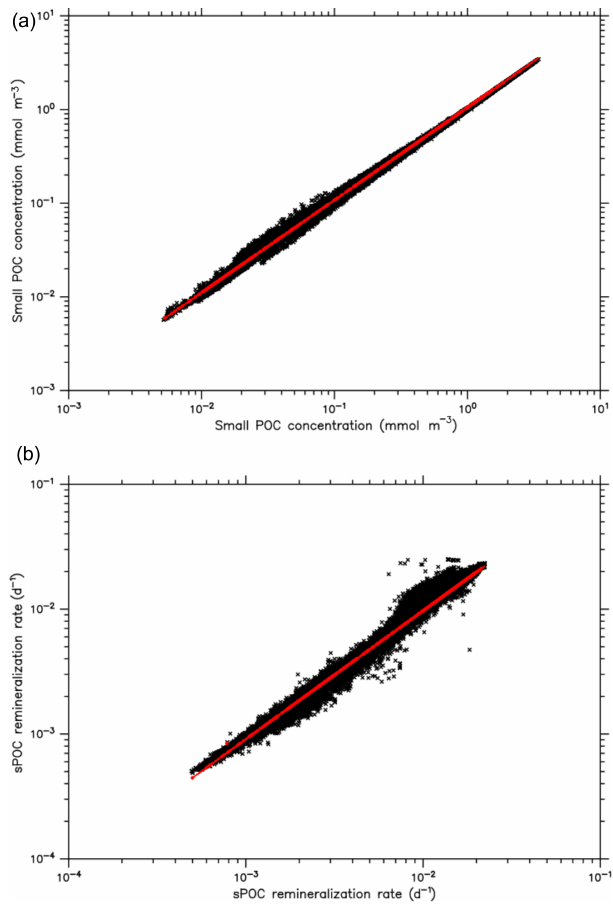
Figure 9. Scatter diagrams of the small POC concentration (in mmolm − 3 , top panel) and the remineralisation rate (in d − 1 , bottom panel). In both panels, the x axis corresponds to the results from a model experiment in which nine lability classes are explicitly mod- elled, whereas the results from the RC experiment are shown on the y axis. The red line on both panels shows a linear regression. In the top panel, the slope is 0.99 and the r 2 is 0.99. In the bottom panel, the slope is 1.03 and the r 2 is